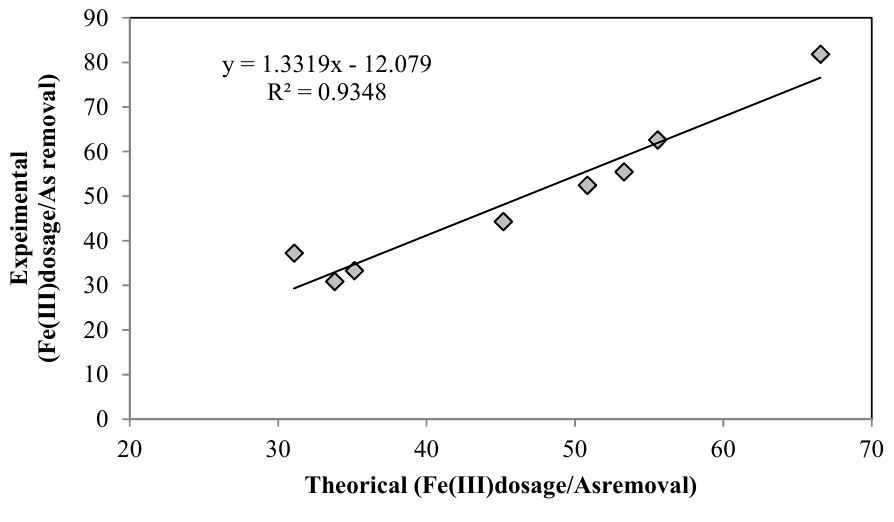
Figure 12. Correlation between experimental and theoretical Fe(III) and As removal in full-scale NCMG